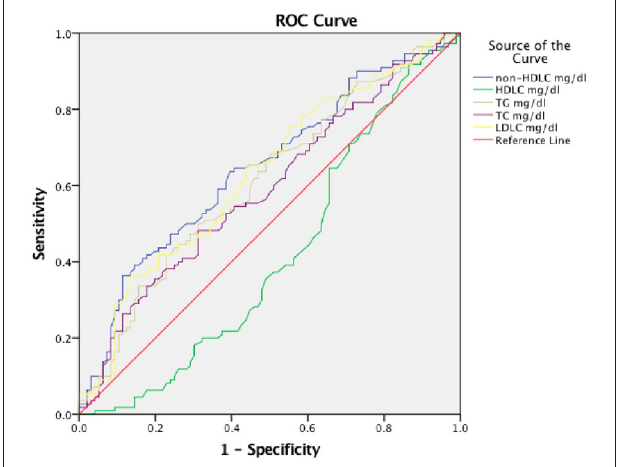
FIGURE 2 | Receiver operating characteristic (ROC) curves for 3-month prognosis according to lipid profiles. TC, total cholesterol; LDLC, low-density lipoprotein cholesterol; non-HDLC, non-high-density lipoprotein cholesterol; TG, total cholesterol; HDLC, high-density lipoprotein